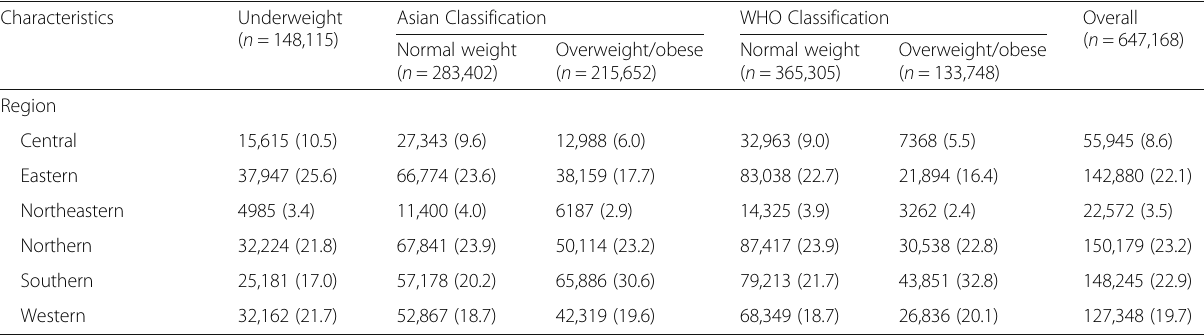
Table 1 Background characteristics of the survey participants according to body weight categories classified by guidelines 1 (Continued)